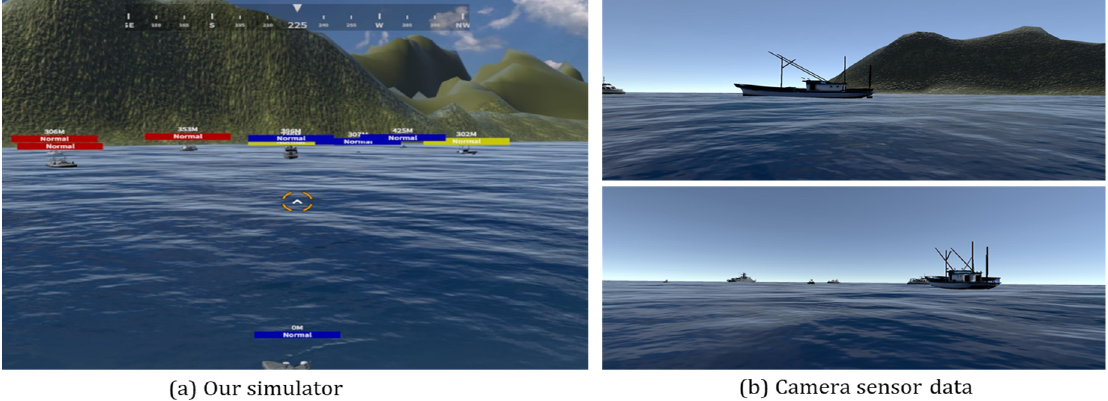
Figure 6. Experimental environment: ( a ) virtual vessel-simulator, and ( b ) virtual camera sensor data. Table 2. Training data overview, including the distribution of images for training and testing.